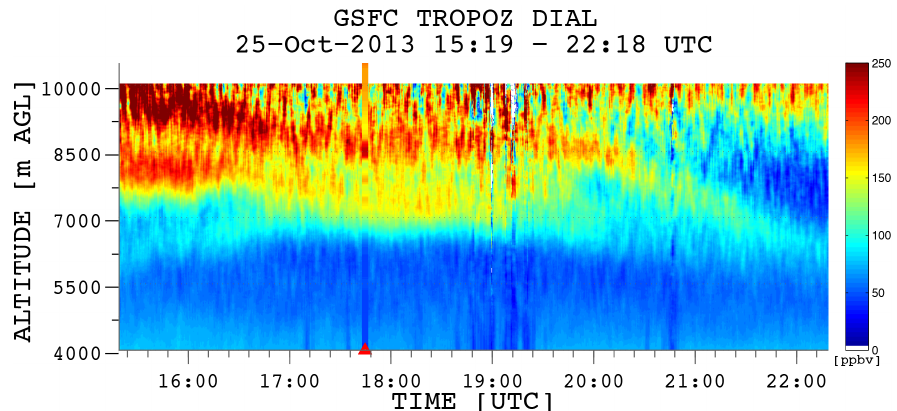
Figure 9b. Time series plot of the ozone mixing ratio [ppbv] from the GSFC TROPOZ DIAL between 15:19 and 22:18UTC (11:19– 18:18EDT) at a 1min temporal resolution, with the colocated ozonesonde launch corresponding to the red arrow point at 17:44UTC. This plot focuses attention on the upper atmospheric conditions in order to represent the ability to monitor the changing dynamics of the ozone reservoir on a very short